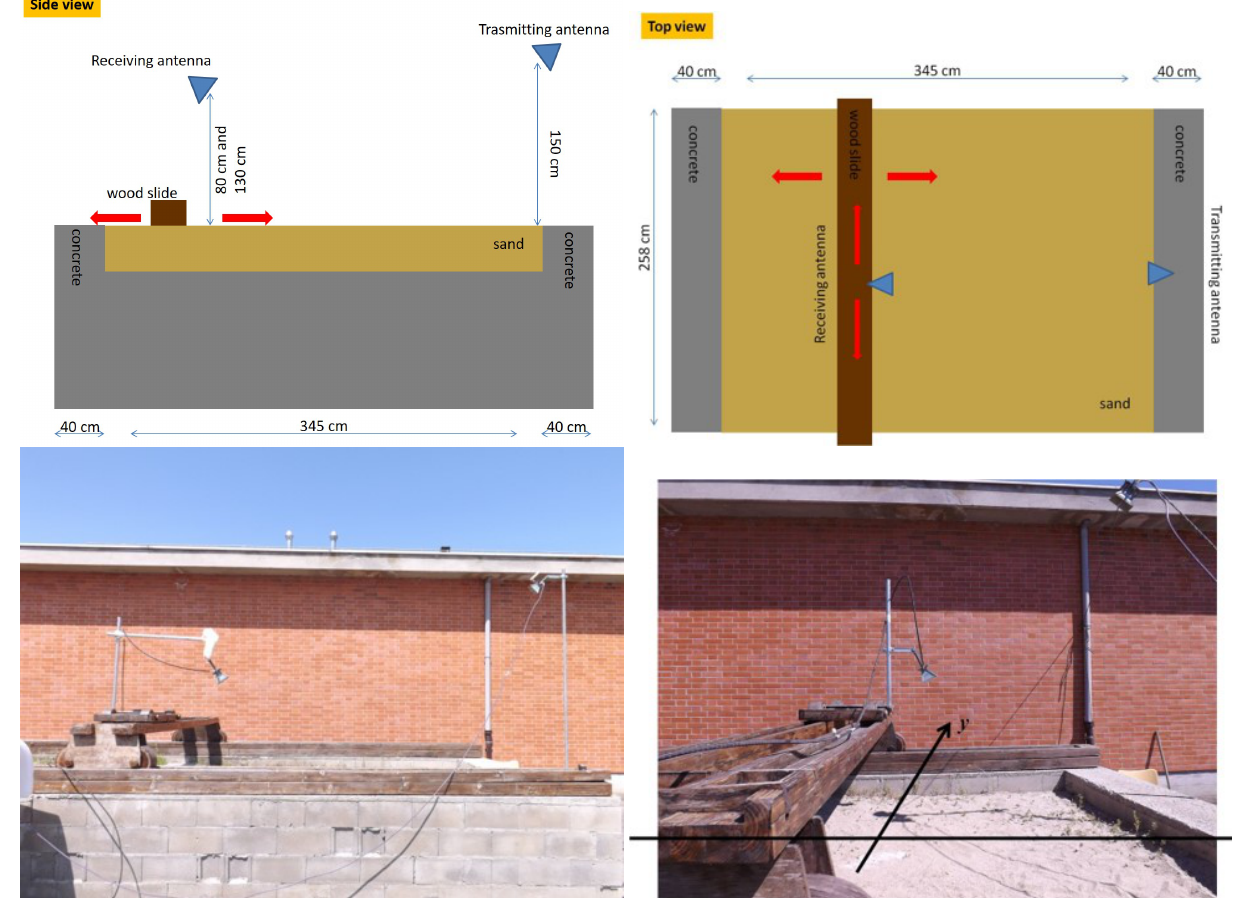
Figure 2. Schematic view of the measurement configuration ( top ) and photos of the test site ( bottom